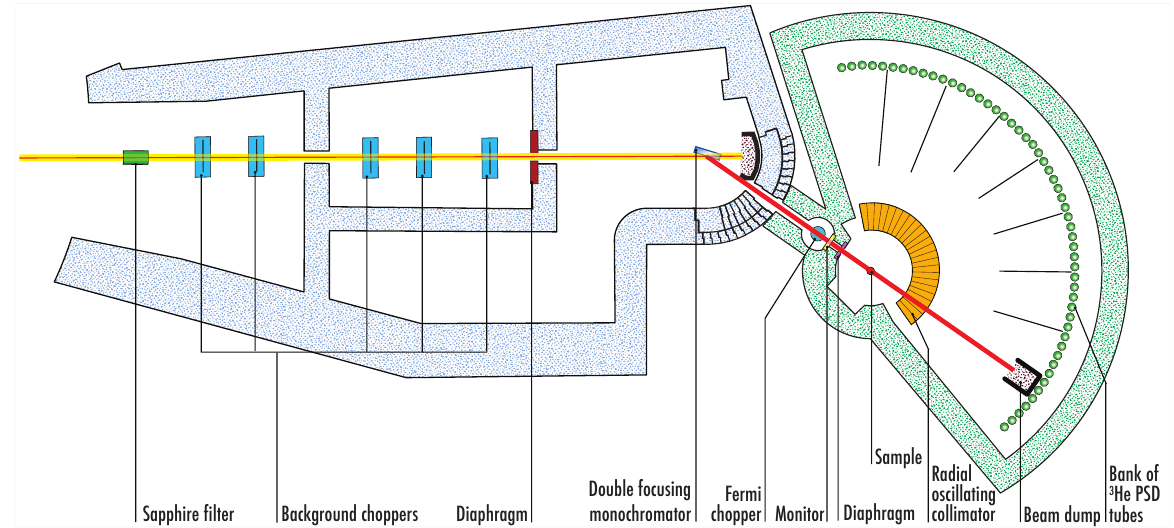
Figure 1. Schematic plan of Panther.